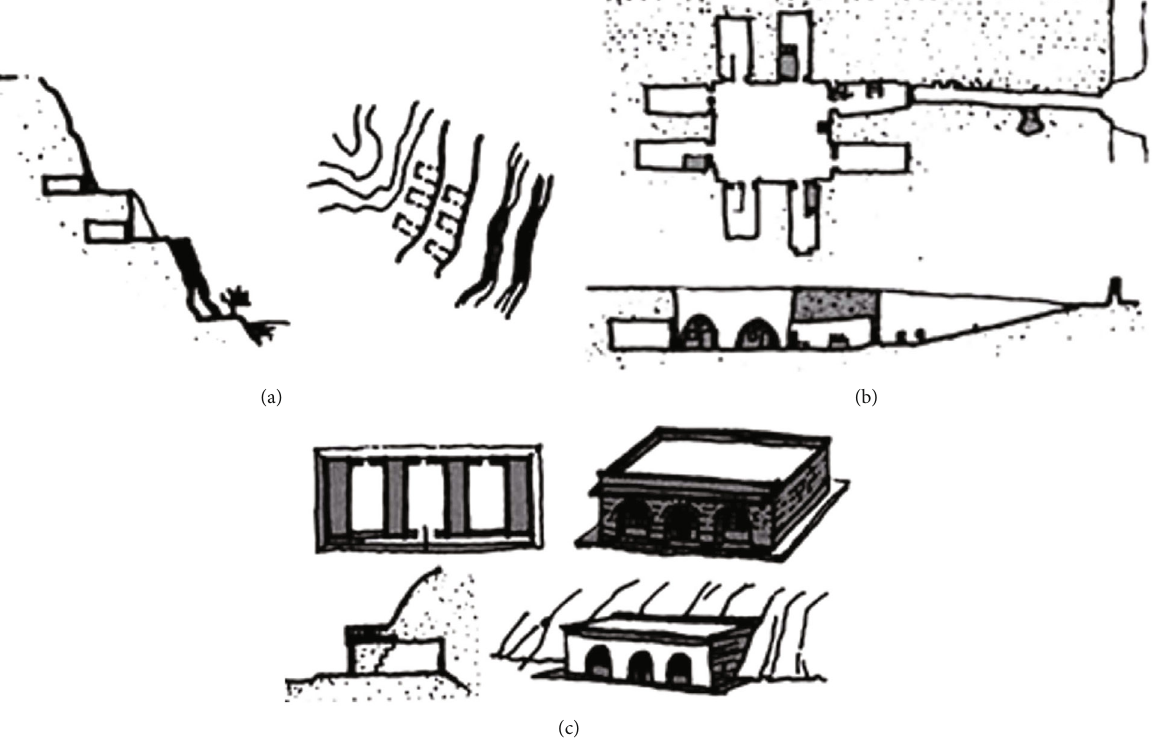
Figure 1: Three types of cave dwellings: (a) cli ff -side pattern; (b) sunken pattern; (c) freestanding pattern.